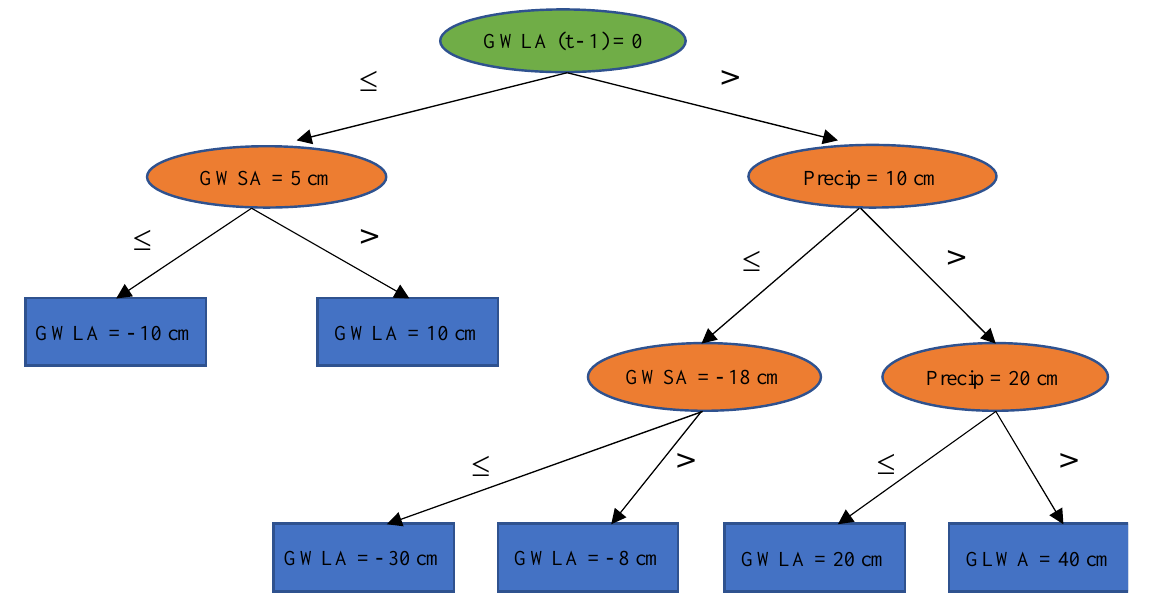
Figure 2. Conceptualised schematic of a traditional decision tree to determine the groundwater level change (GWLA). The root node is coloured green, intermediate split nodes are orange, and leaf nodes are blue. Data are routed through the split node based on rules/conditions until a leaf node (i.e., decision) is reached. GWLA (t − 1) = Previous groundwater level change, GWSA = Groundwater storage anomaly, Precip = Precipitation.